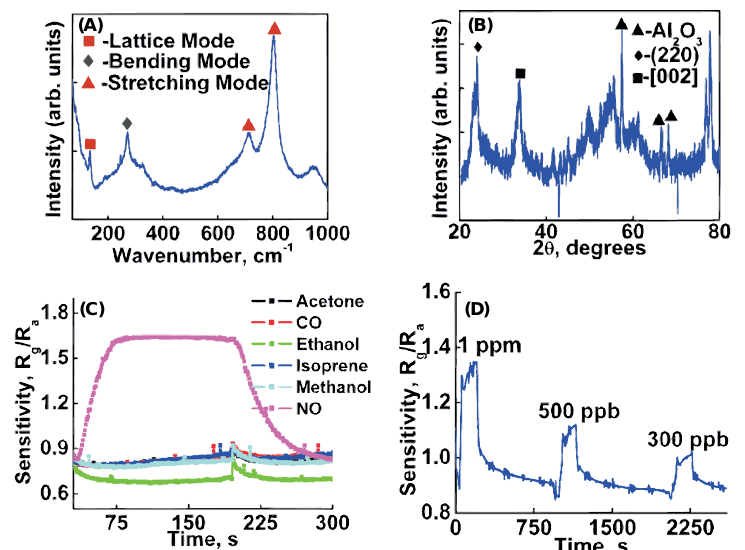
Figure 4. Gouma et al. has found that the gas selectivity is strongly dependent on the crystal phase. ( A ) A raman spectrum taken of the monoclinic γ -WO 3 sample; ( B ) A XRD spectrum taken of the monoclinic γ -WO 3 sample; ( C ) Gas sensing response of the monoclinic γ -WO 3 sample to 10 ppm NO, 10 ppm acetone, 10 ppm isoprene, 50 ppm ethanol, 50 ppm methanol, and 50 ppm CO in synthetic air; ( D ) Gas sensing response of the monoclinic γ -WO 3 sample to 1 ppm, 500 ppb, and 300 ppb NO in synthetic air. Reprinted from [30] with the permission of AIP Publishing. Table 8. A list of different samples used to detect NO.